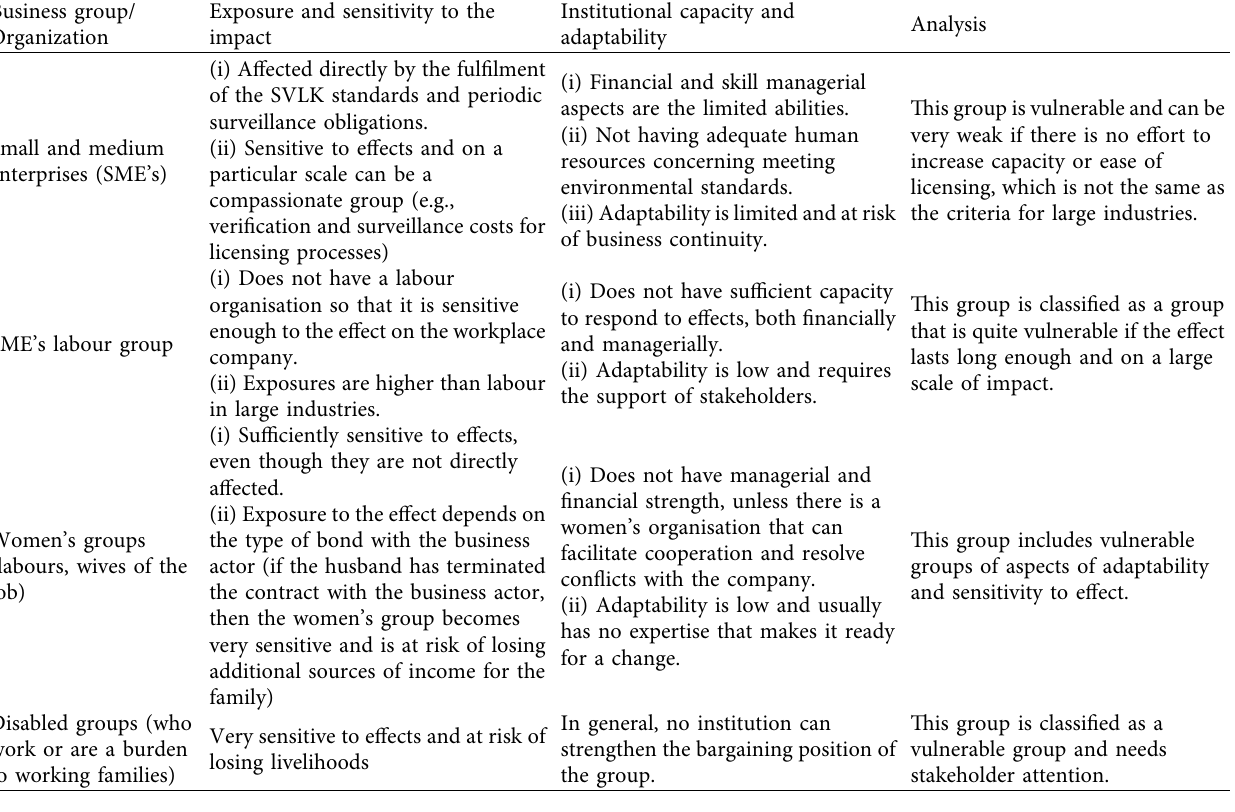
Table 3: Vulnerable analysis of